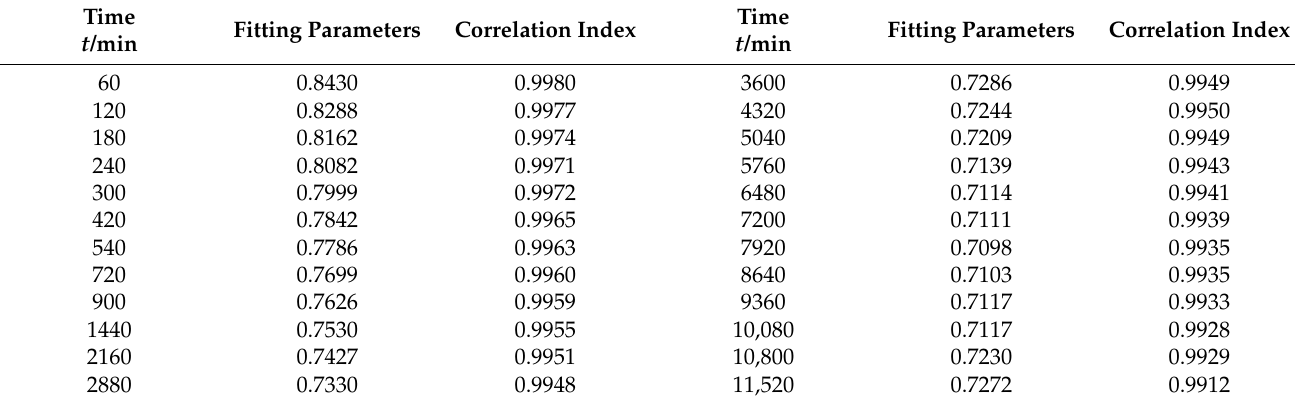
Table 8. Fitting parameters of lg σ -lg ε relation of Changsha sandy soil.